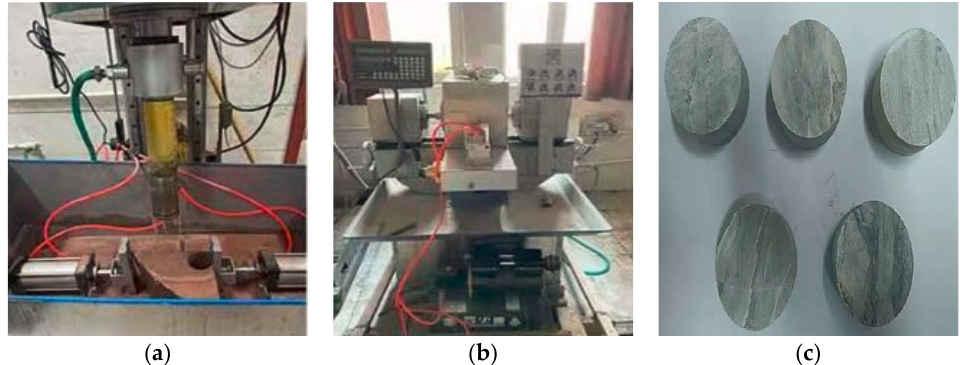
Figure 3. Specimen processing equipment and specimen preparation. ( a ) CNC core machine; ( b ) CNC grinding machine; ( c ) Prepared specimen.